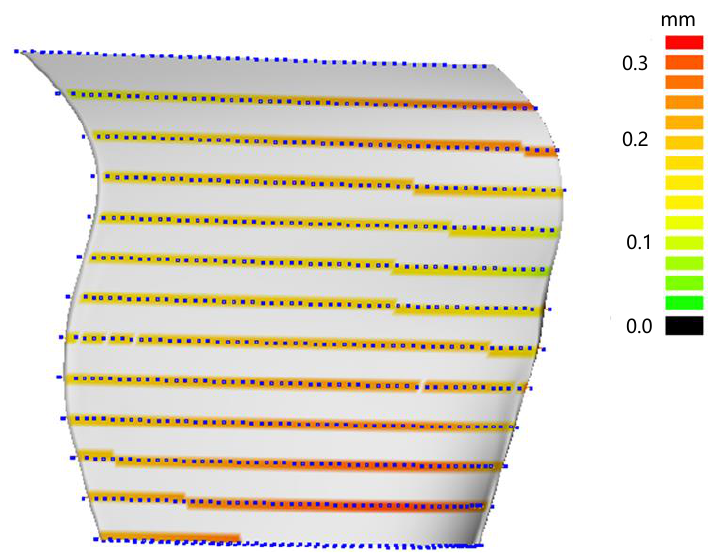
Figure 10. Material distribution on the to-be-cut blade surface by material-constraint optimization.